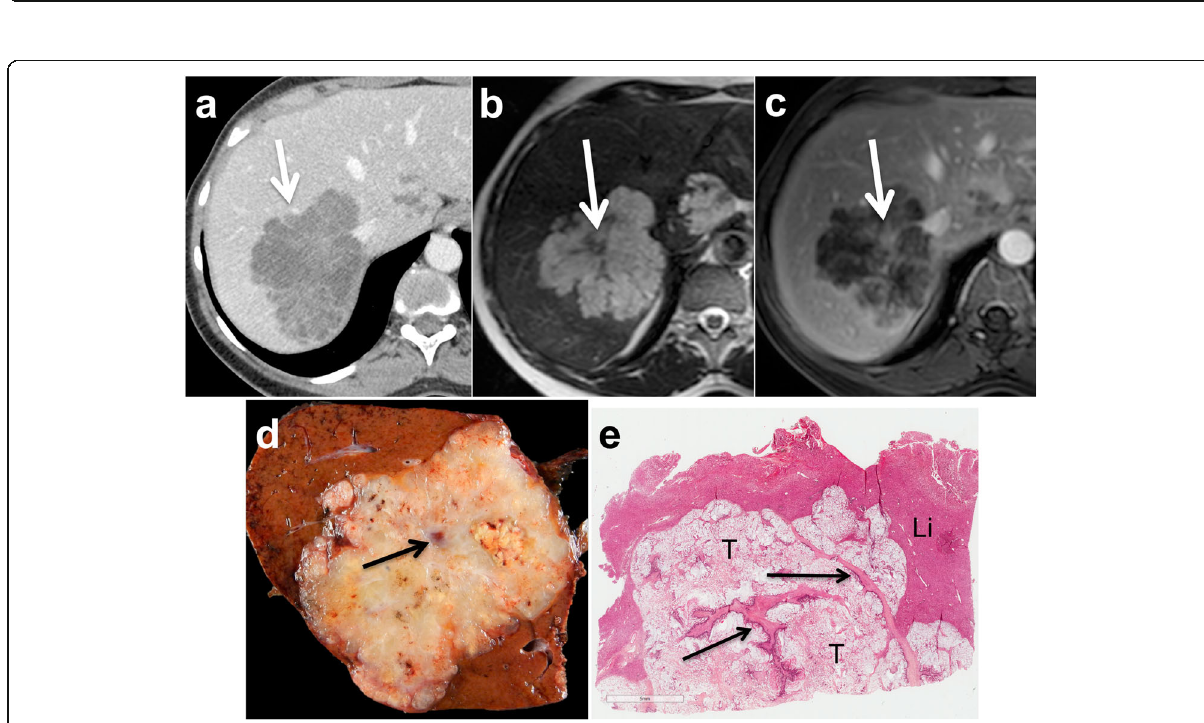
Fig. 8 Mucinous metastasis containing fibrosis in a 47-year-old female patient. Portal venous phase contrast-enhanced CT image ( a ) shows a polylobubated well-delineated hypo-attenuating 70 mm tumor (arrow) in the right liver lobe. Note the presence of subtle inner enhancing septa. The lesion is bright on fast spin echo T2-weighted image ( b ) and contains inner hypointense septa (arrow). The gadobenate dimeglumine- enhanced fat-saturated gradient recall echo T1-weighted image obtained during the delayed phase (3 min) ( c ) shows enhancement of central fibrous septa (arrow). Gross pathology ( d ) and histology ( e ) show mucin pools (T) crossed with thick fibrous bands (black arrows). The lesion is well-separated from the liver (Li), consistent with a pushing growth